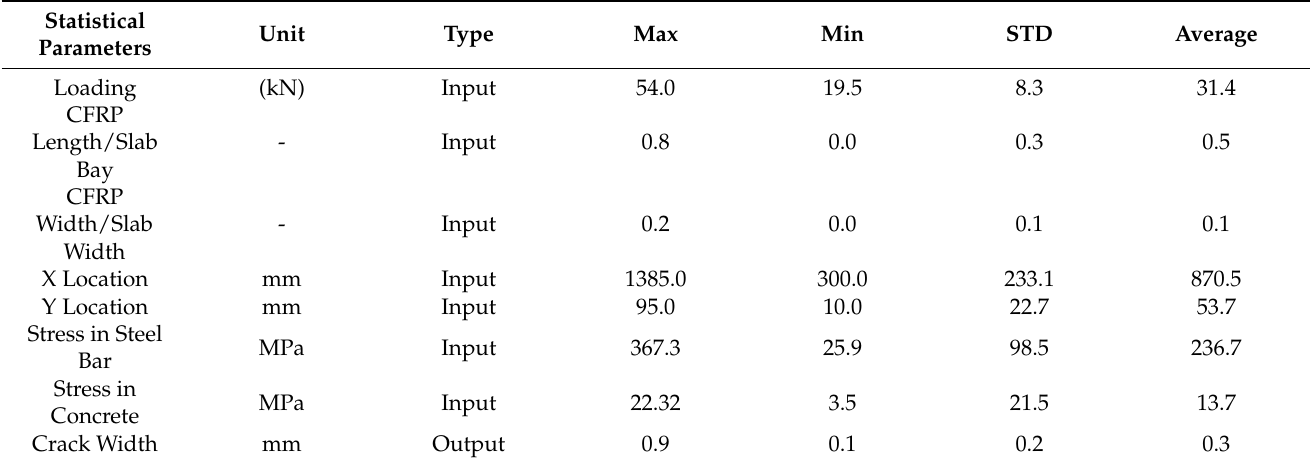
Table 12. Properties of the used